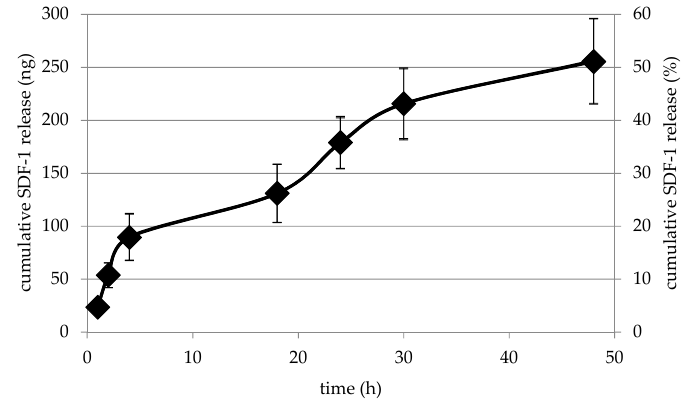
Figure 6. SDF-1 release from PLA collagen cages. SDF-1 is released from collagen inside the 3D-printed cages in a steady manner and after 48 h approximately 50% are still inside the cage.